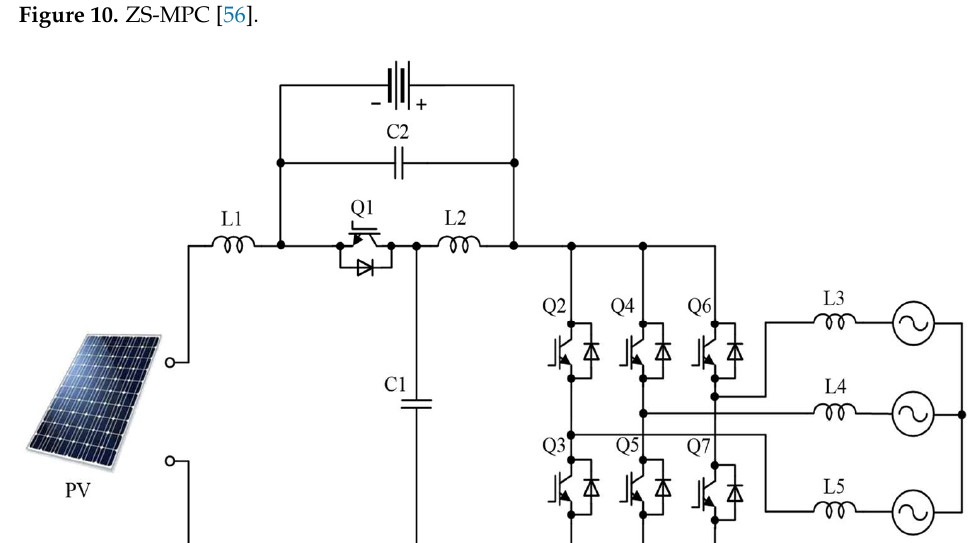
Figure 10. ZS-MPC [56].